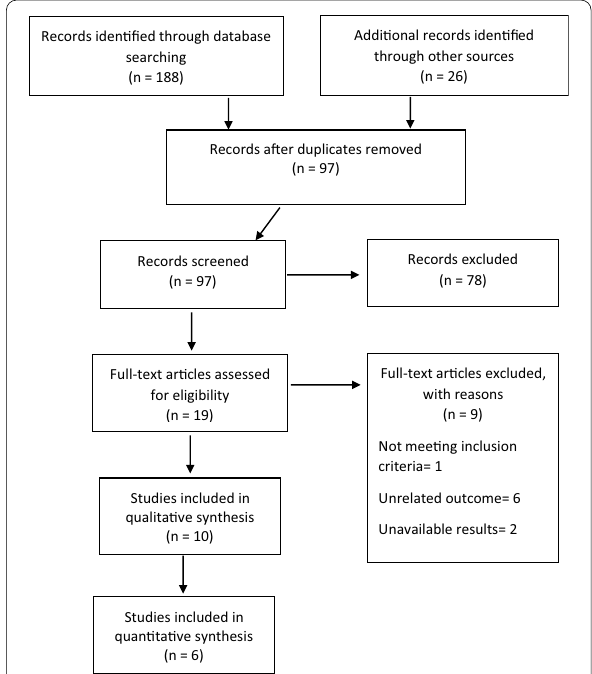
Fig. 1 PRISMA flow diagram detailing the search process and studies